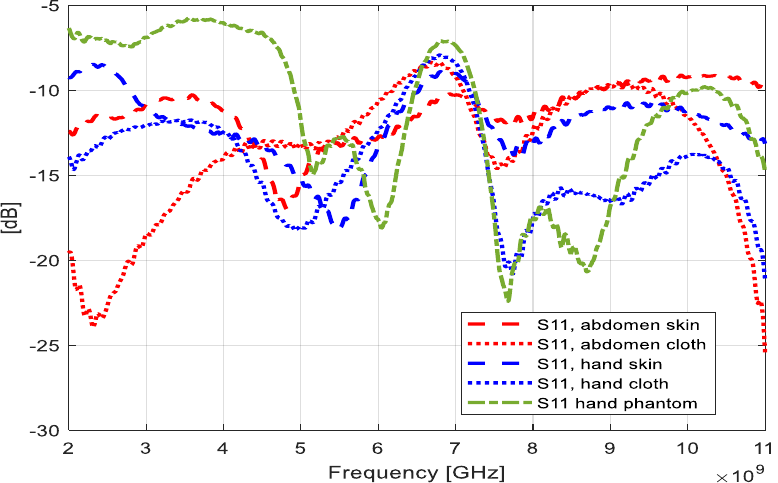
Figure 8. Measured S11 in different cases: antenna set on the hand phantom (green line), on the volunteer’s hand with and without the cloth between the antenna and the skin (blue lines), volunteers abdomen with and without the cloth between the antenna and the skin (red lines).